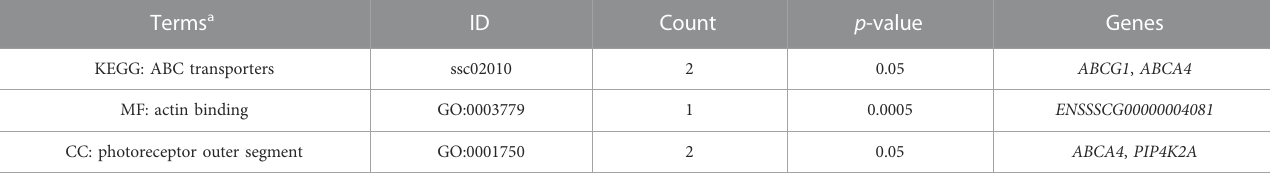
TABLE 5 Signi fi cant GO terms and KEGG pathways associated with meat quality traits in crossbred pigs ( p ≤